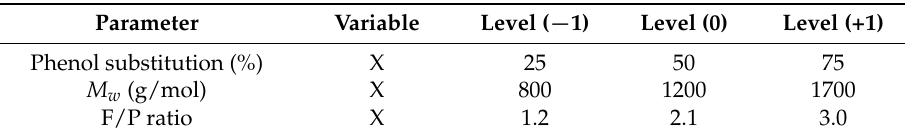
Table 10. Coded Values of the Variables for the Box-Behnken